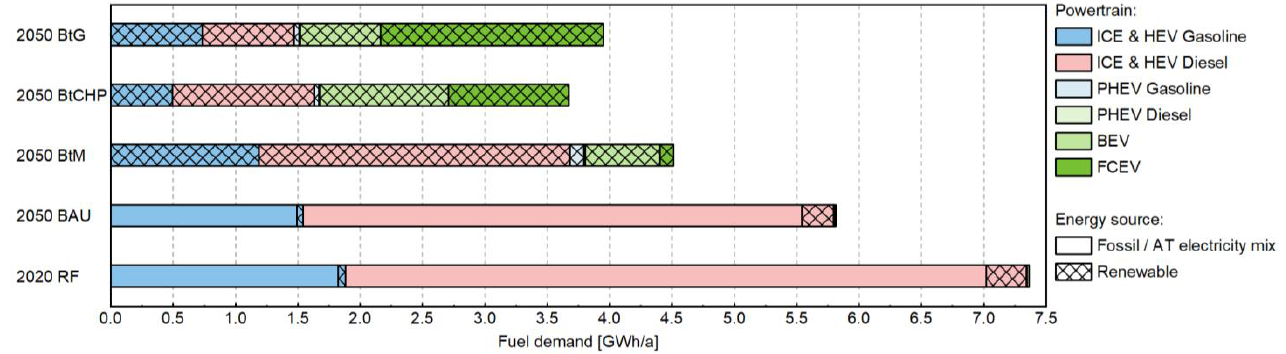
Figure 8. Comparison of final fuel demand of the reference case (2020) with assumed scenarios (2050).